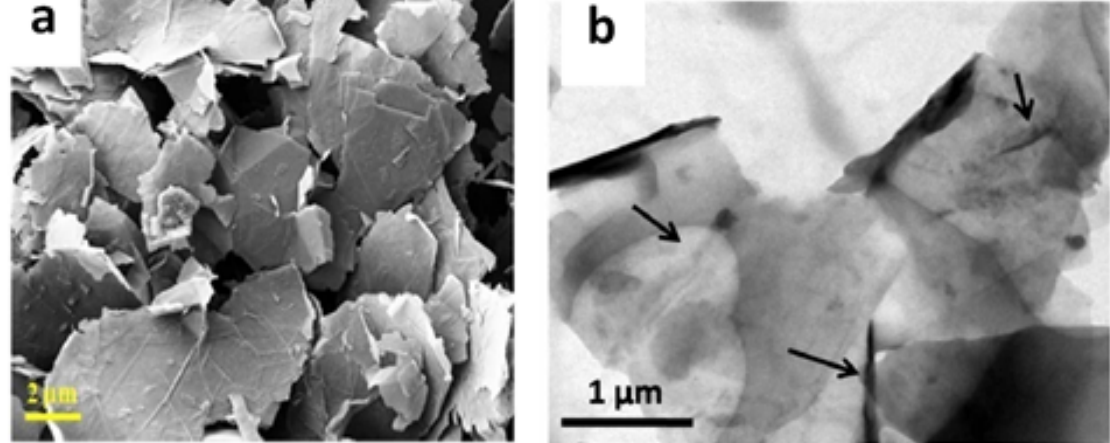
Figure 4: (a) SEM images of GNP powders and (b) TEM images of sonicated GNPs. Reproduced from Reference